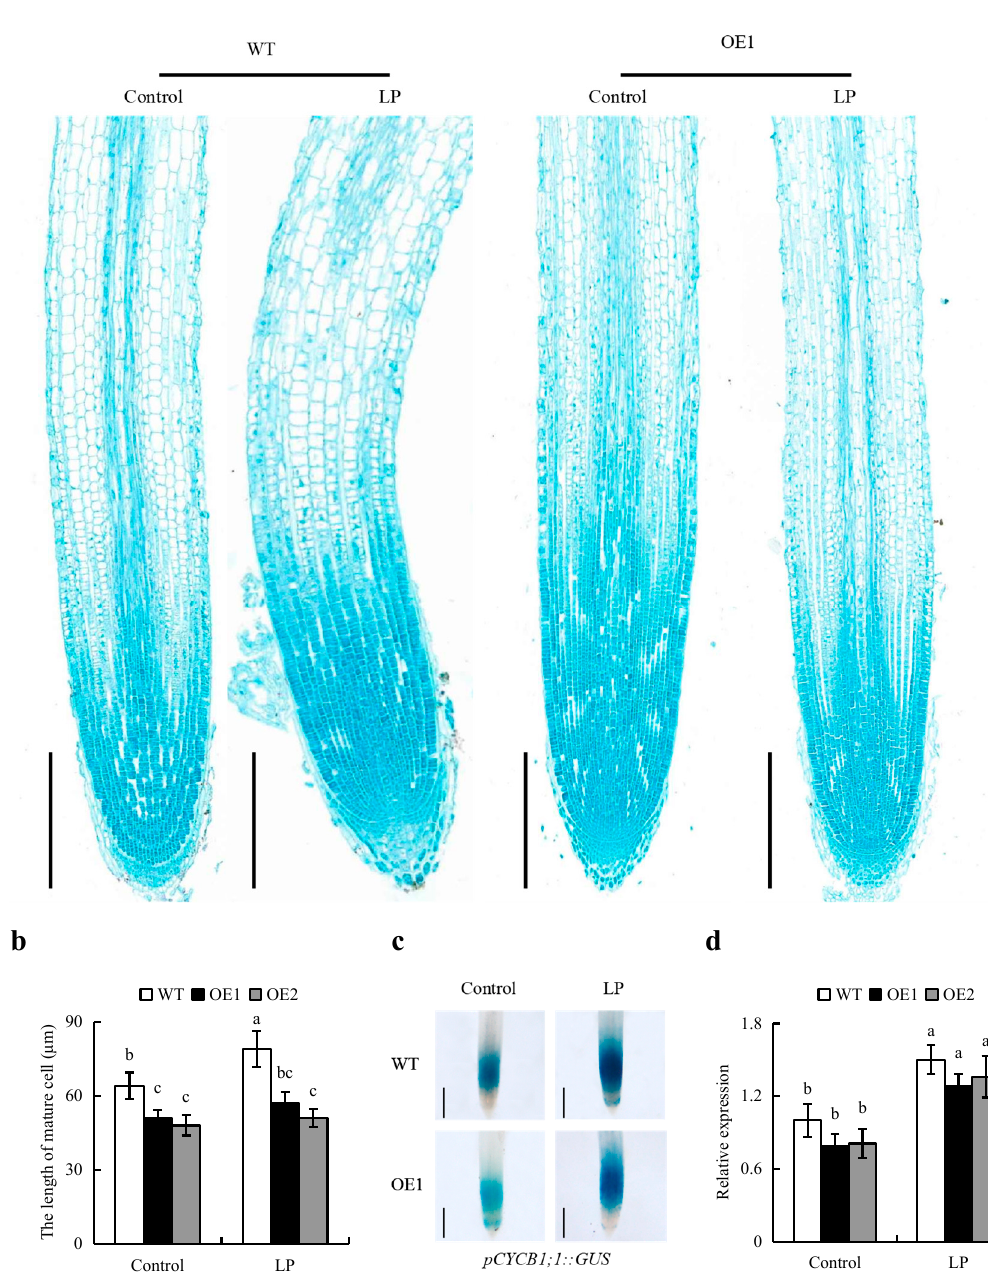
Figure 4. The epidermal cell lengths in the maturity zone and expression levels of CYCB1;1 in the meristem zone in rice plants. Seedlings were grown in hydroponic medium containing normal nutrition (control, 300 μ M P) and low P (LP, 10 μ M) for 7 d. ( a , b ) Epidermal cell length of seminal root, Bar = 500 μ m. ( c ) Cell cycle activity of the root meristem of seminal root, as monitored by the pCYCB1;1::GUS reporter. ( d ) The expression of OsCYCB1;1 by qRT-PCR. Bar = 1mm. d = days. Data are means ± SE and bars with different letters indicate significant difference at p < 0.05 tested with ANOVA. All experiments included three independent biological replicates.